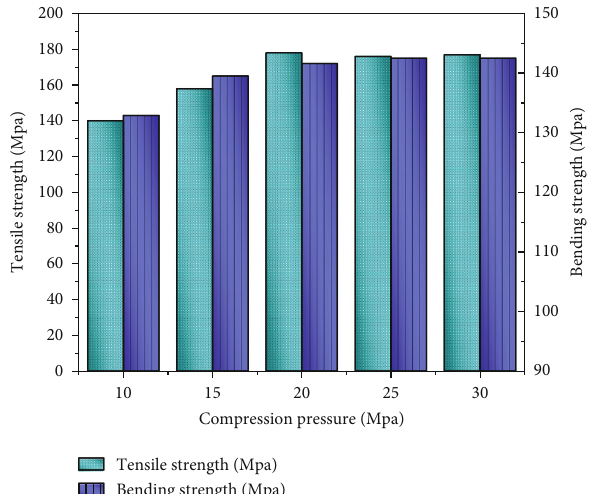
Figure 6: Tensile and bending strength as a result of compression pressure.